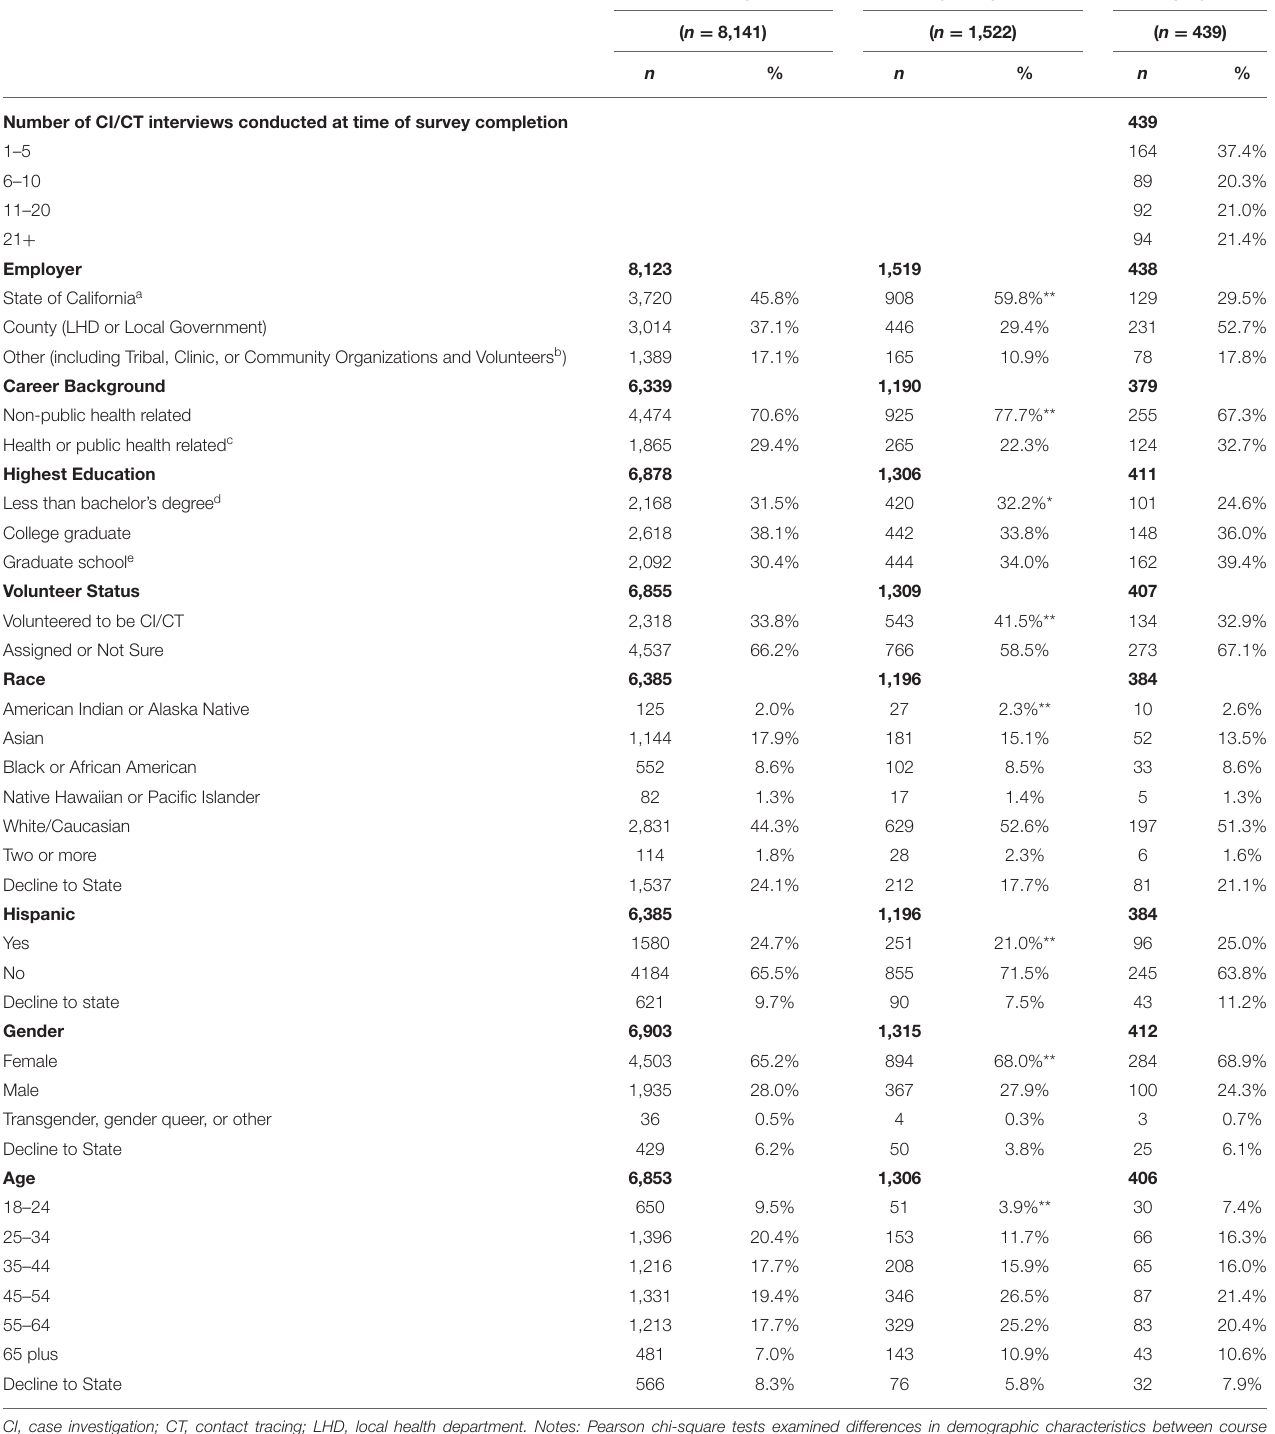
Course completers Survey